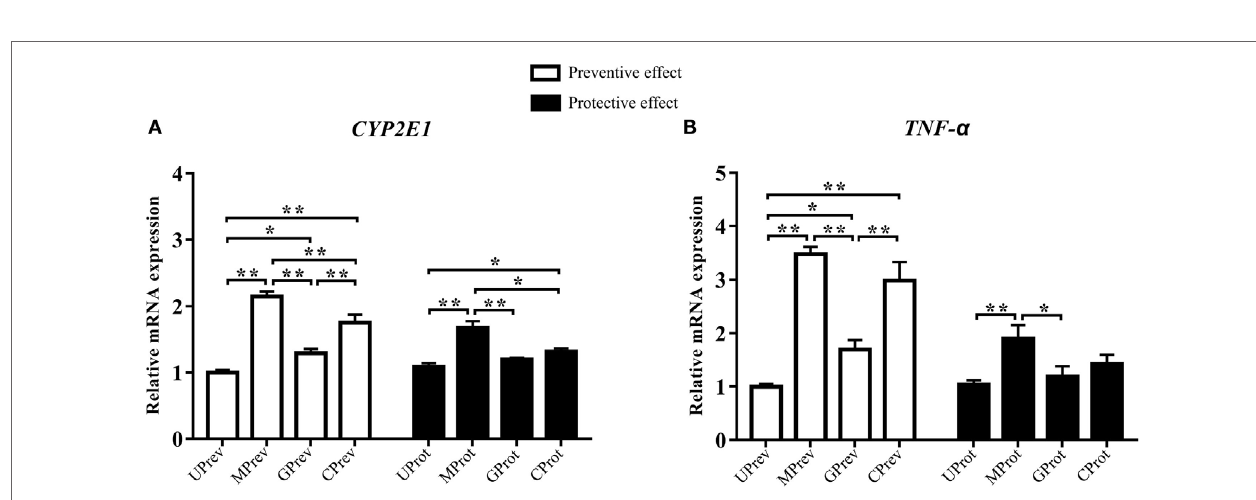
FigUre 3 | Relative expression levels of two key genes CYP2E1 (a) and TNF- α (B) in liver tissue from mice in the different treatment groups (see Figure 1a ). Samples were taken 1 day after administration of CCl 4 (to determine preventive effects of milk consumption on induced liver injury) from: untreated control mice (UPrev), model mice (MPrev), mice receiving goats’ milk (GPrev), and mice receiving cows’ milk (CPrev) and 8 days after administration of CCl 4 (to determine protective effects of continued milk consumption on induced liver injury) from untreated control mice (UProt), model mice (MProt), mice receiving goats’ milk (GProt), and mice receiving cows’ milk (CProt). The data and error bars are presented as mean ± SEM. * P < 0.05; ** P < 0.01.